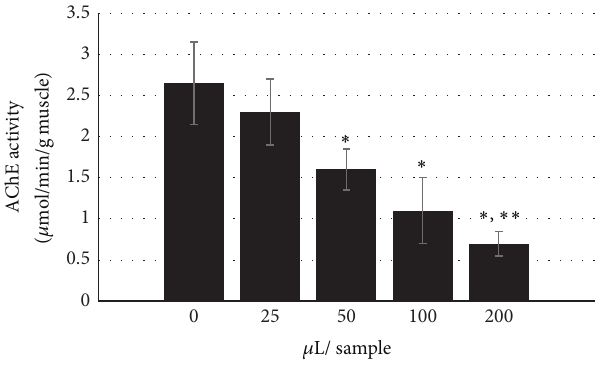
Figure 5: Activity of skeletal muscle homogenate AChE in the in the presence of different volumes of pooled serum Ig fraction from hens ( 𝑛 = 7 ) at 21 days following a single exposure to OPIDP-inducing phenyl saligenin phosphate (PSP, 2.5 mg/kg, im). This confirms that serum elements, possibly the detected anti-AChE, may interfere with neuromuscular function as observed in the isolated muscle preparations (see Figure